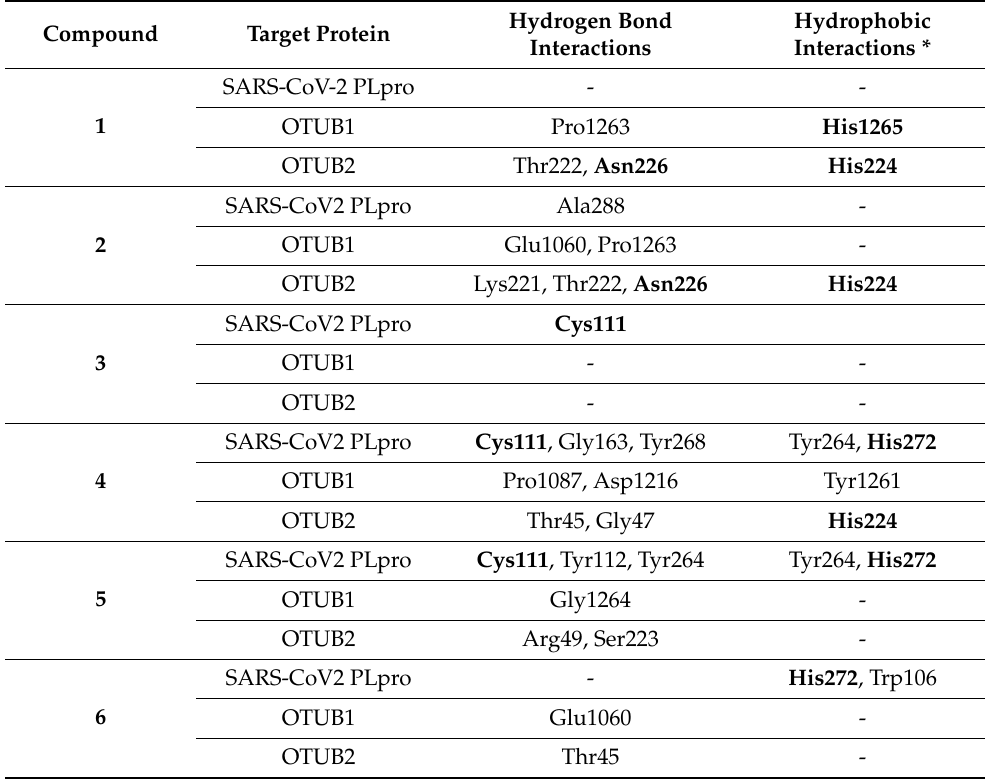
Binding of covalent and non-covalent SARS-CoV PLpro inhibitors to SARS-CoV- 2 PLpro, OTUB1, and OTUB2. Analysis of relevant hydrogen bonding and hydrophobic protein-ligand